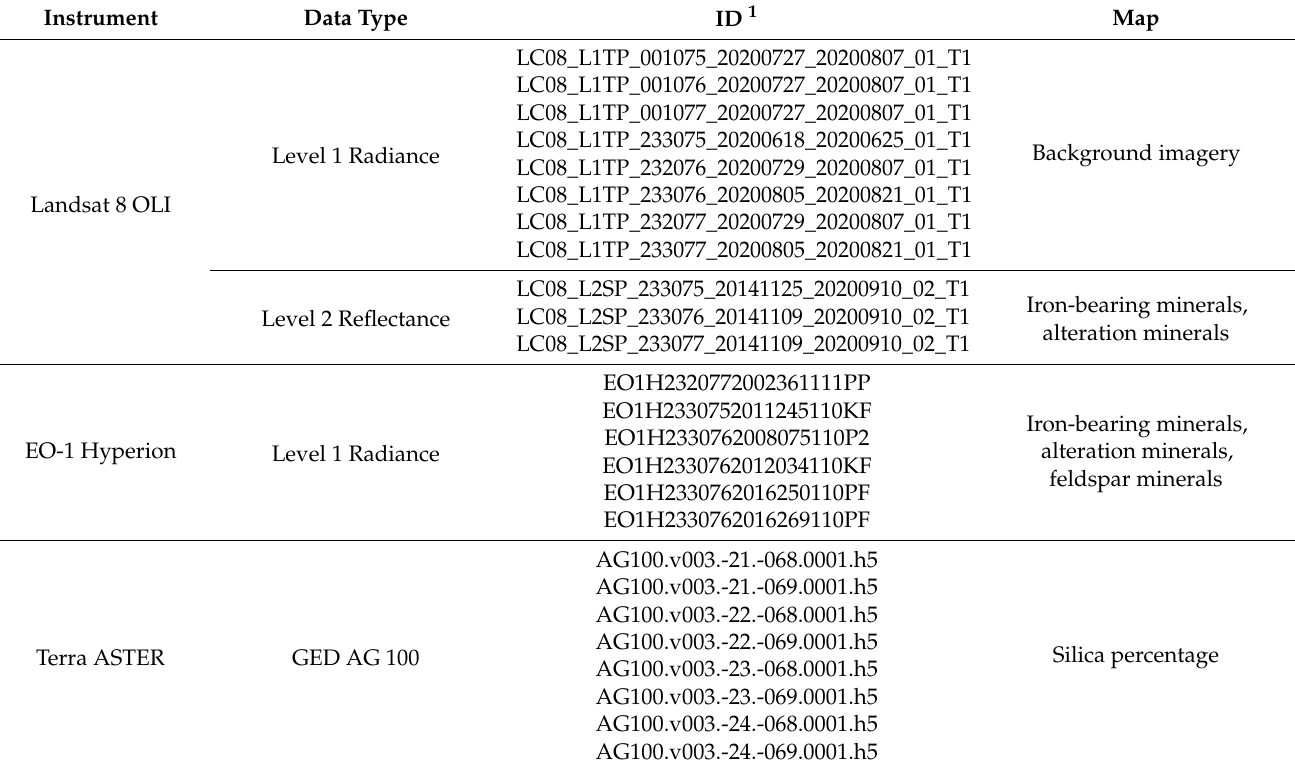
Table A1. Summary of remote sensing-data used in this